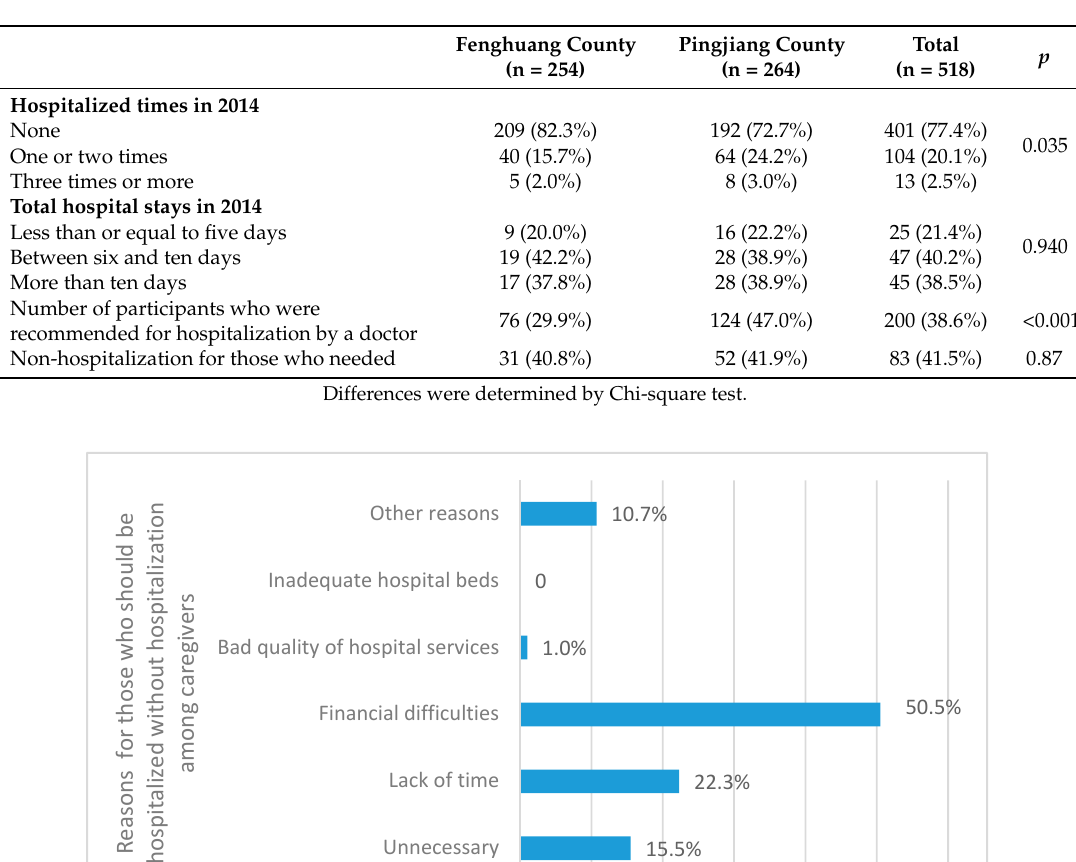
Table 4. Hospitalization among CLBC (n, %).